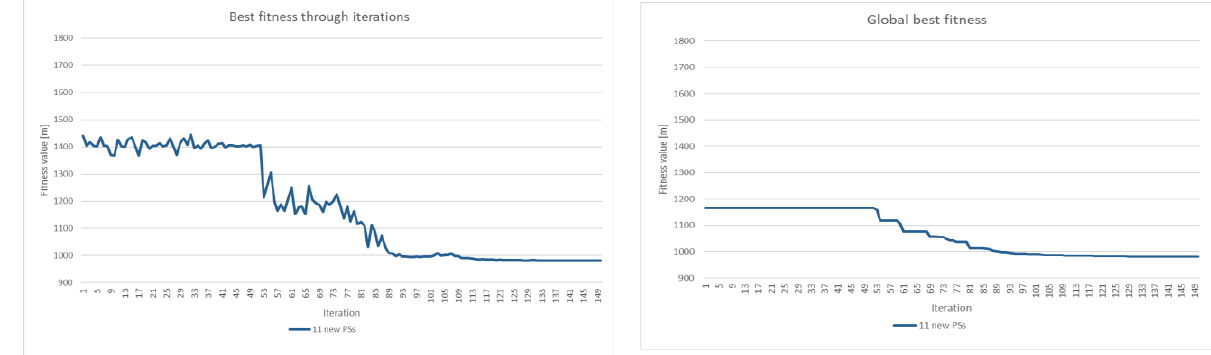
Figure 27. Best fitness through iterations and the global best fitness: eleven new PSs.